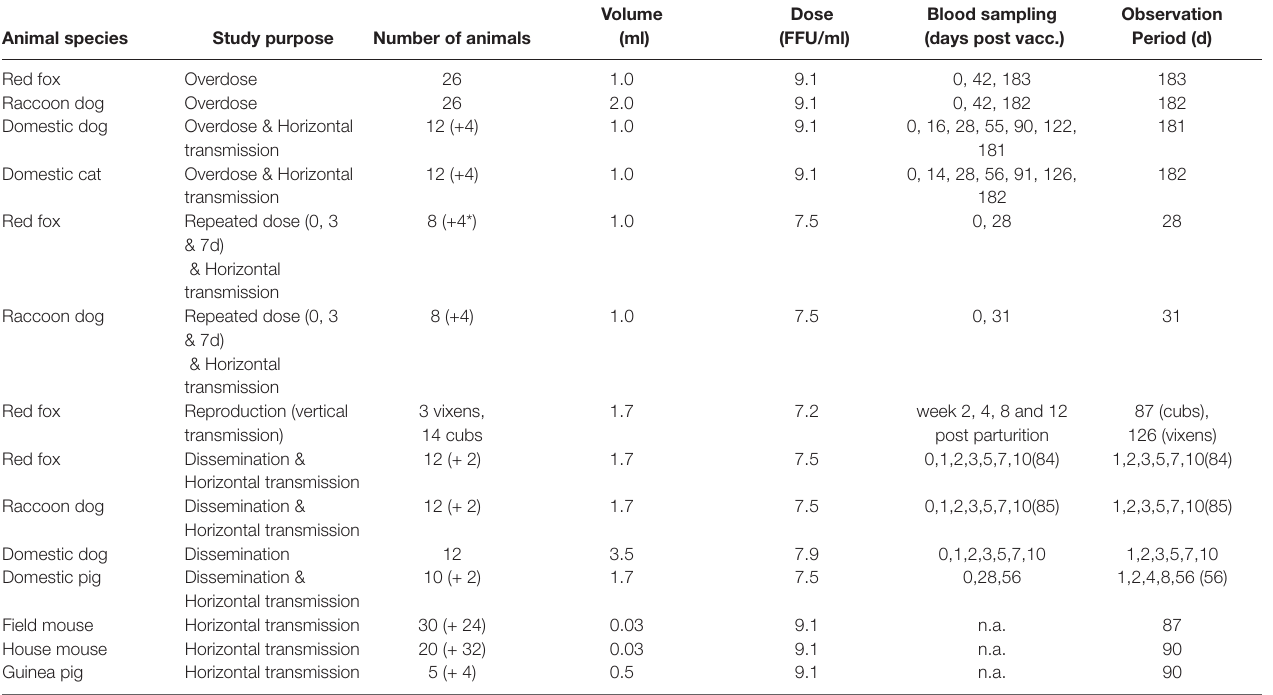
taBle 1 | Overview table of animal studies performed (except for reproduction study all animals received material by direct oral instillation).